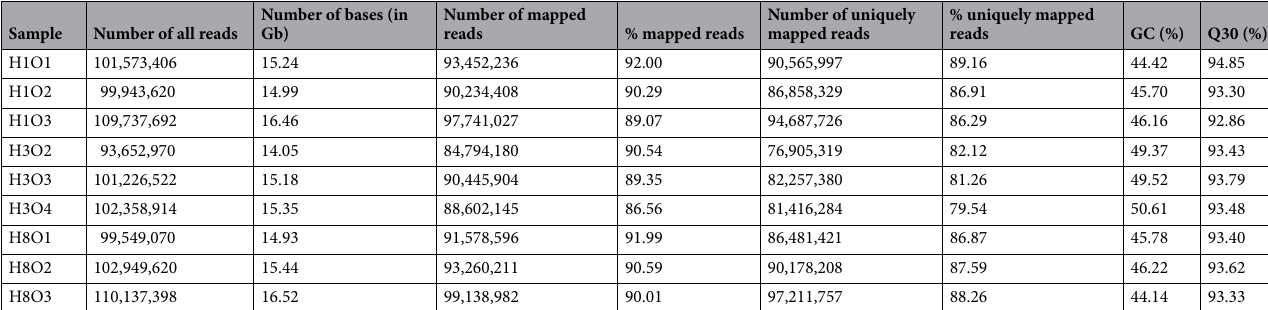
Table 1. Summary of reads of Hu sheep transcriptome. H1O1–H1O3 refers to 3 ovaries of Hu sheep at 1 month old; H3O2–H3O4 refers to 3 ovaries of Hu sheep at 3 months old and H8O1–H8O3 refers to 3 ovaries of Hu sheep at 8 months